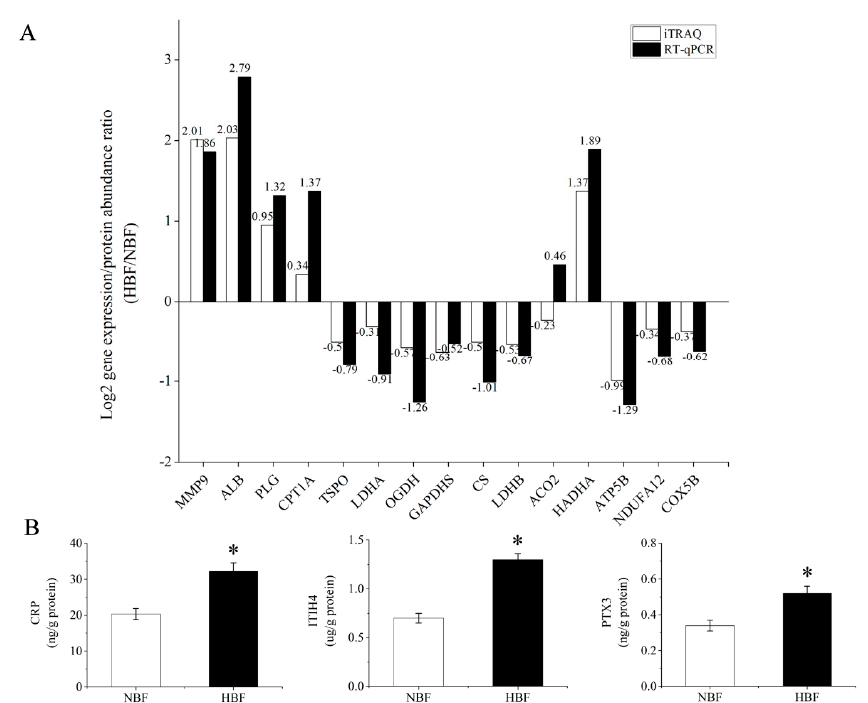
Figure 5. Validation of the DAPs using RT-qPCR and ELISA analysis. ( A ) Fifteen DAPs between the HBF and NBF placentas were selected. The expression ratios (HBF/NBF) of the genes encoding these DAPs are shown in parallel with protein abundance ratios identified by iTRAQ proteomics for comparison convenience. Log2 gene expression/protein abundance ratio (HBF/NBF) >0 indicates that the gene expression/protein abundance is up-regulated in the HBF placentas compared to the NBF placentas. ( B ) The expression levels of CRP, ITIH4 and PTX3 obtained at ELISA analysis. n = 30 biological replicates in each group. * p < 0.05.